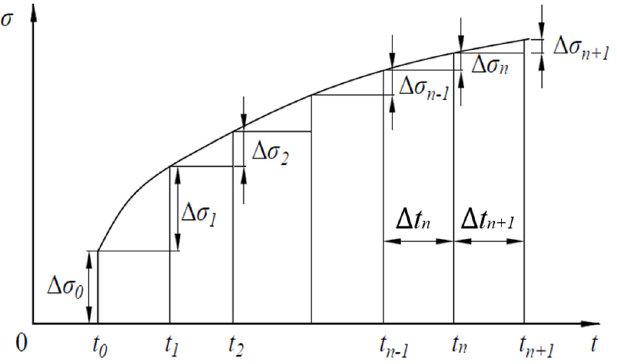
Figure 3. The relationship between the stress increment and time used in the calculations of the USERMAT subroutine.